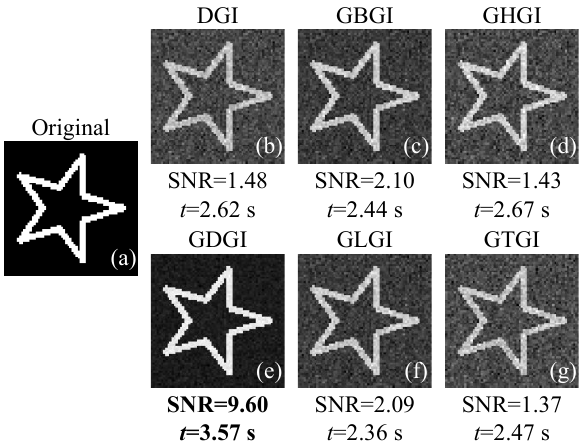
Figure 2. Simulation results of the binary image “01” using different ghost imaging (GI) algorithms with m = 20,480 measurements. ( a ) is the original image “01”, ( b – g ) are the images recovered by the differential GI (DGI), gradient-descent-like background-removal GI (GBGI), gradient-descent- like high-order GI (GHGI), gradient-descent-like DGI (GDGI), gradient-descent-like logarithmic GI (GLGI) and gradient-descent-like trigonometric GI (GTGI), respectively, with their signal-to-noise ratios (SNRs) and running time t marked below the